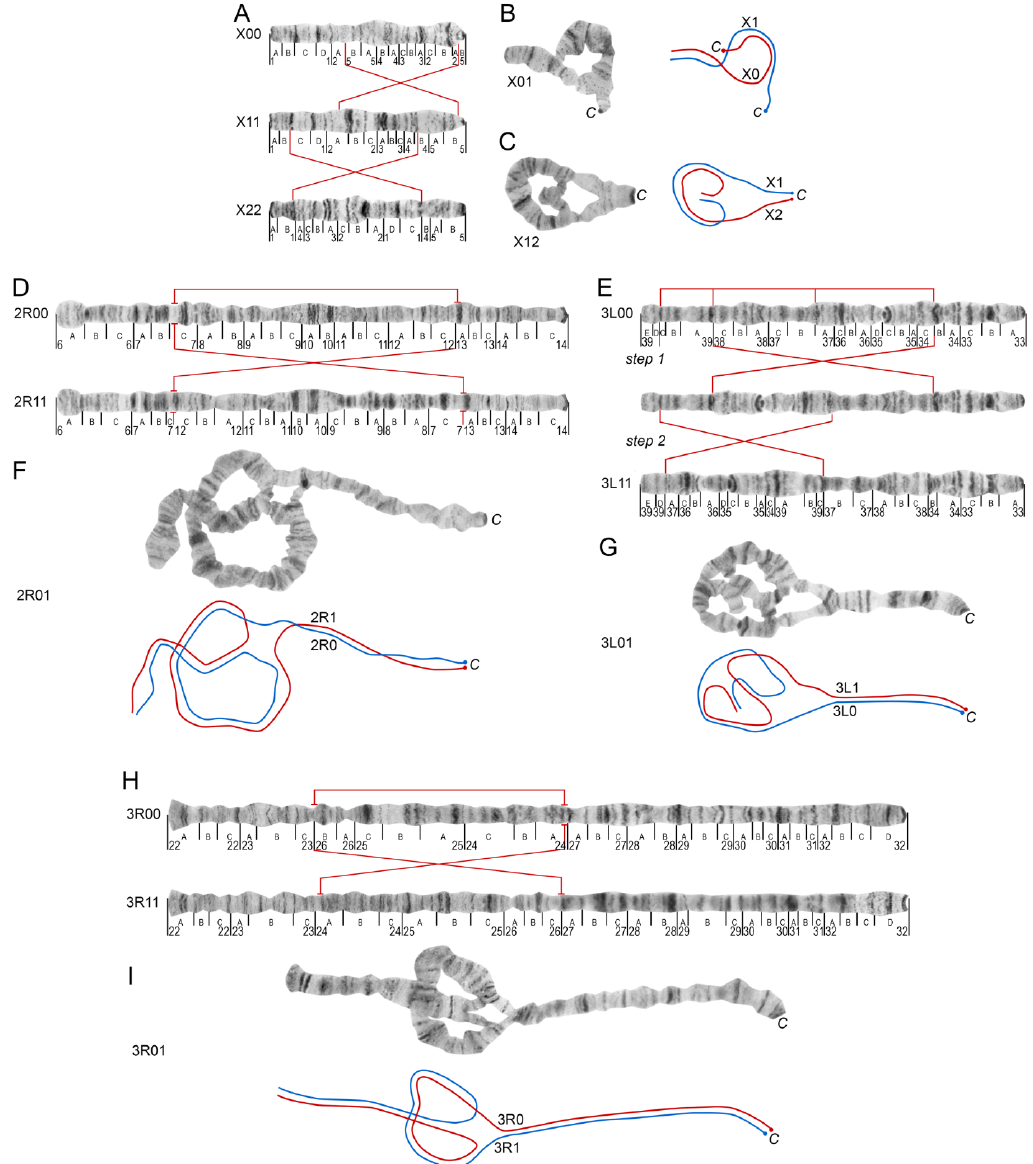
Figure 3. Maps for the chromosomal inversions in Anopheles messeae and Anopheles daciae. Maps for homokaryotypes X00, X11, X22 in chromosome X are shown in panel ( A ). The numbered divisions (1–39) and lettered subdivisions ( A – E ) are shown below the straight chromosome images. Straight red lines indicate the cytogenetic positions of inversion breakpoints and their connections between standard and inverted karyotypes. Curved red and blue lines indicate a schematic representation of standard and inverted arrangements, respectively, tracing the axes of homologues. The letter C stands for a centromere end. Heterokaryotypes X01 and X12 are shown in panel ( B , C ), respectively. Chromosome maps for the 2R arm for homokaryotypes 2R00 and 2R11 are shown in panel ( D ). Chromosome maps of the inversions in the 3L arm of An. daciae and An. messeae for homokaryotypes 3L00 and 3L11 are shown in panel ( E ). The 3L1 arrangement is expected to originate through two steps, which are shown by crossed red lines in “step 1” and “step 2” (panel ( E )). An intermediate chromosome variant, created in step 1, has never been found in nature and was assembled by the graphic editor. Panel ( F) demonstrates a photographic image of the 2R01 heterokaryotype and its schematic representation. Panel ( G ) demonstrates a photographic image of the 3L01 heterozygous variant and its schematic representation. Finally, chromosome maps of the 3R11 inversion of An. messeae and An. daciae are shown as homozygotes 3R00 and 3R11 in panel ( H ) and as the heterozygous variant 3R01 in panel ( I ).